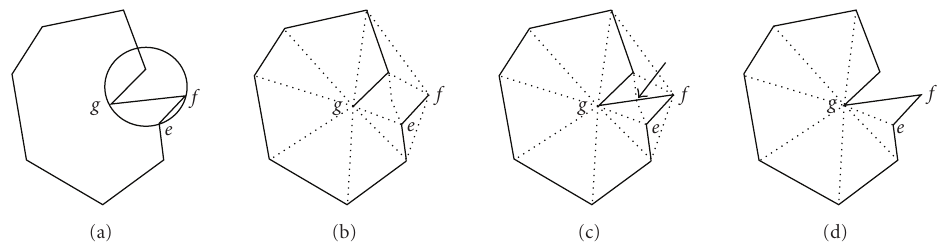
Figure 8: (a) A contour. It is evident that triangle e , f , g cannot be a part of a Delaunay triangulation, since its circumcircle would contain another site. (b) shows the Delaunay triangulation of the contour points. (c) Contour edge e , f is contained after addition of a vertex to. (d) Elimination of exterior edges, added vertex, and the edges related to this vertex.